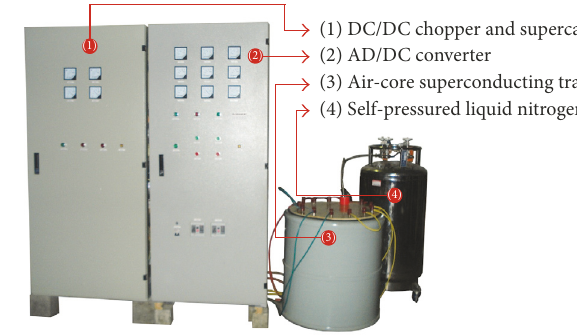
Figure 5: Physical diagram of the active SFCL prototype.